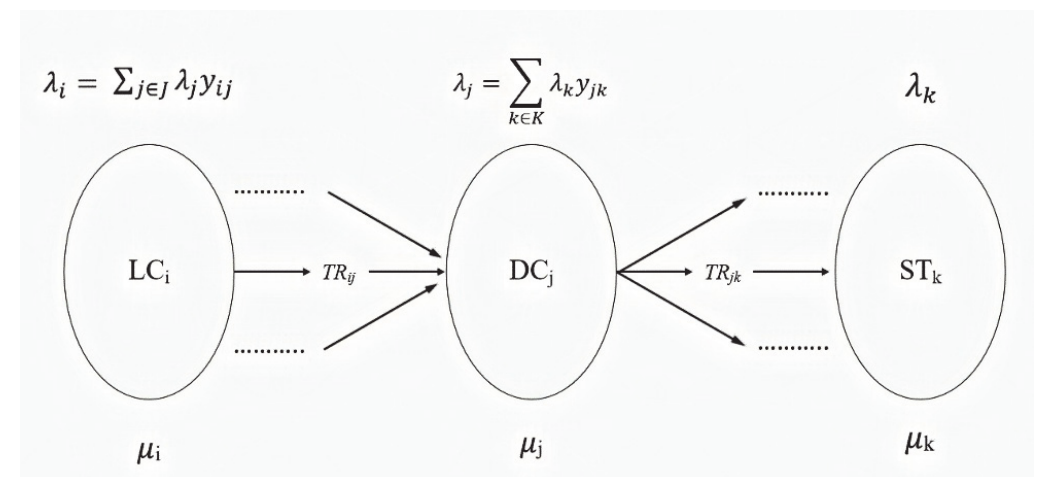
Fig. 2. Queuing system of city logistics distribution